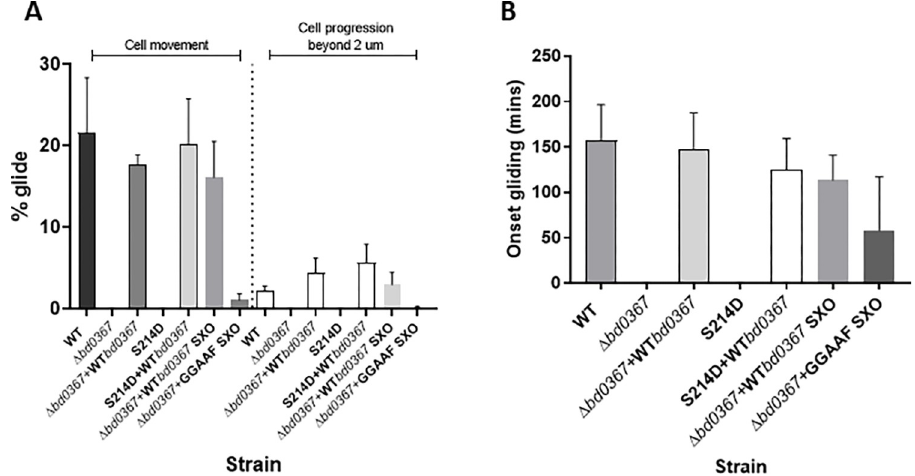
Fig 6. Gliding phenotype of bd0367 mutant strains. A. Time-lapse microscopy was carried out over 7 hours, on a 1% agarose surface, to investigate the percentage of each B . bacteriovorus population able to glide after application from a liquid culture onto a solid surface. Two values are shown for each strain, one for the mean percentage of cells in the population that are able to move on a solid surface (any type of solid surface movement observed), and another for the mean percentage of cells that glide and progress further than 2 μ m. Error bars show one standard deviation of three biological repeats. Both the B . bacteriovorus bd0367 deletion ( Δ bd0367 ) and bd0367 (S214D) site-directed mutant strains were unable to glide. There was no significant difference in the gliding abilities of the strains that are able to glide (one-way ANOVA with Tukey’s multiple comparisons test–Cell movement: HID13 vs Δ bd0367+ WT bd0367 , p = 0.64; HID13 vs bd0367 (S214D)+WT bd0367 , p = 0.94; Δ bd0367 +WT bd0367 vs bd0367 (S214D)+WT bd0367 , p = 0.8. Cell progression beyond 2 μ m: HID13 vs Δ bd0367+ WT bd0367 , p = 0.35; HID13 vs bd0367 (S214D) +WT bd0367 , p = 0.08; Δ bd0367 +WT bd0367 vs bd0367 (S214D)+WT bd0367 , p = 0.62). Gliding of the GGAAF complemented strain ( Δ bd0367 +GGAAF SXO) was significantly less ( p = 0.0044 for cell movement, p = 0.0327 for cell progression by unpaired t -test) than the control single crossover strain ( Δ bd0367 +WT bd0367 SXO). B. The time taken for each strain to initiate gliding (onset of gliding) over the 7 hour time-lapse. The mean onset of gliding ( ± standard deviation, 3 biological repeats) of the complementation strains were found to not significantly differ ( Δ bd0367 +WT bd0367 = 2.47 ± 0.66 hrs; bd0367 (S214D)+WT bd0367 = 2.08 ± 0.57 hrs) to the host-independent wild type strain gliding onset (HID13 = 2.62 ± 0.6 hrs) (one-way ANOVA with Tukey’s multiple comparisons test: HID13 vs Δ bd0367 +WT bd0367 , p = 0.95; HID13 vs bd0367 (S214D)+WT bd0367 , p = 0.53; Δ bd0367 +WT bd0367 vs bd0367 (S214D) +WT bd0367 , p = 0.71). Onset of gliding was not significantly different ( p = 0.21 by unpaired t -test) for the GGAAF complemented strain ( Δ bd0367 +GGAAF SXO) compared to the control single crossover strain ( Δ bd0367 +WT bd0367